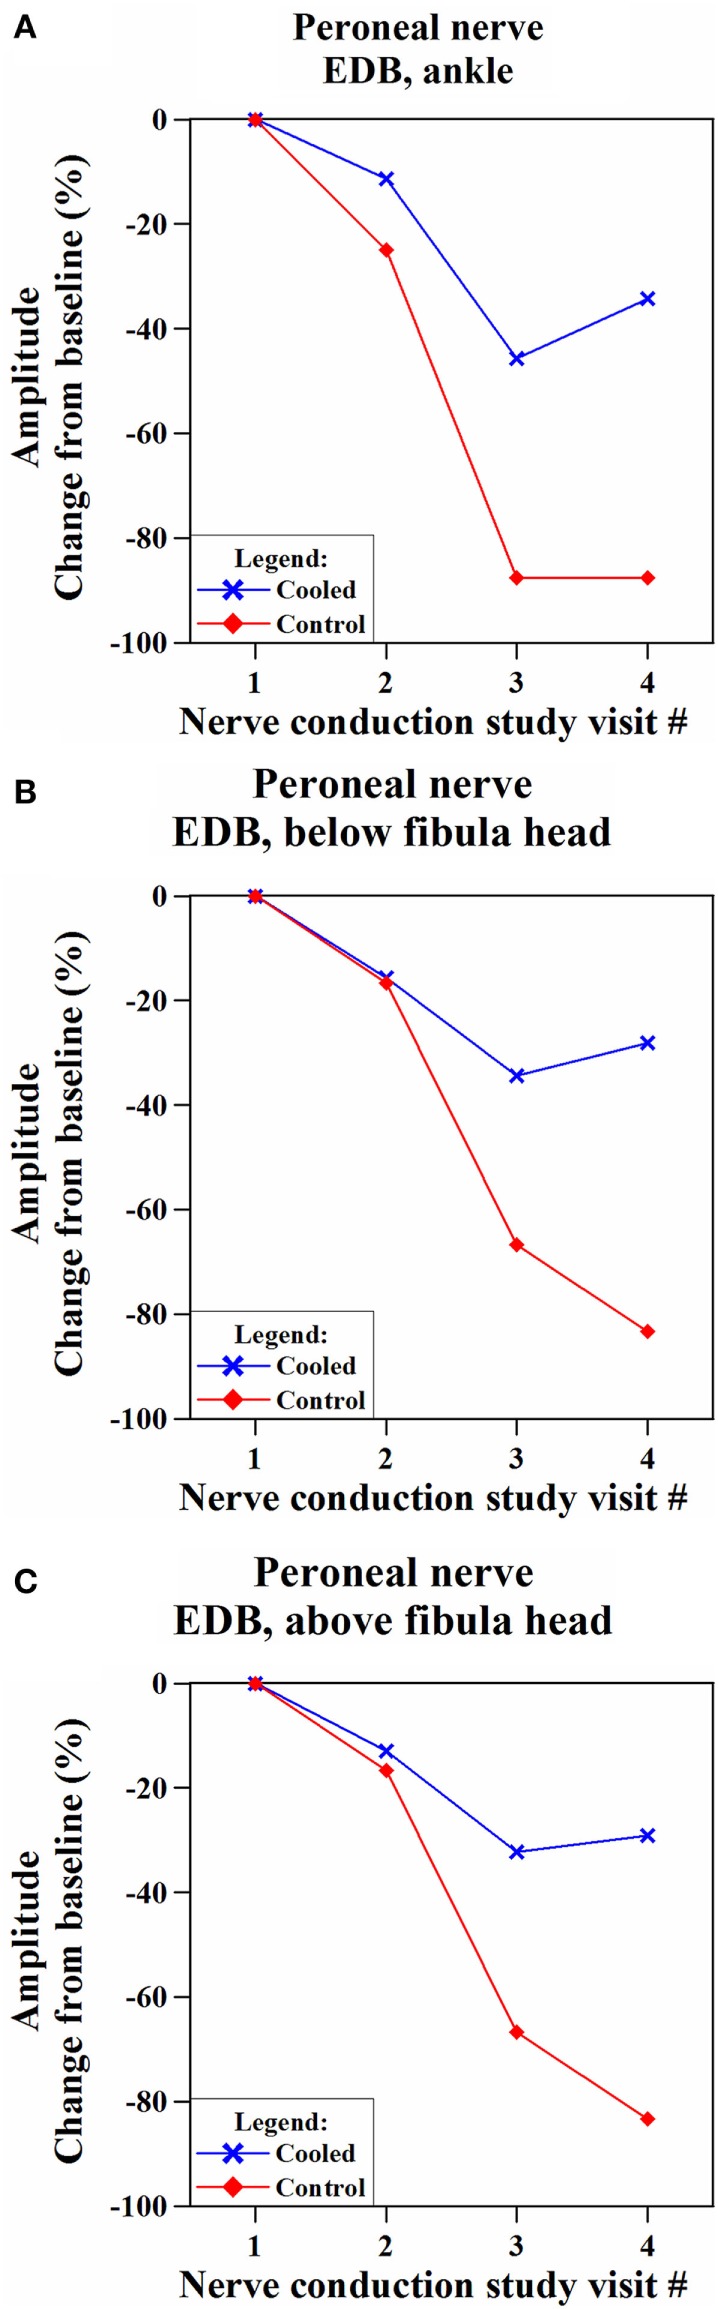
Comparison of changes in compound motor action potential (cMAP) amplitudes in the cooled and non-cooled limb of a subject with well-preserved cMAP amplitudes in the extensor digitorum brevis (EDB) muscle on the common peroneal nerve. Over the time, the cooled leg showed consistently more preserved compound motor action potential amplitudes than the control leg at all the three stimulation points [(A) ankle, (B) below fibula head, and (C) above fibula head] on the EDB muscle.